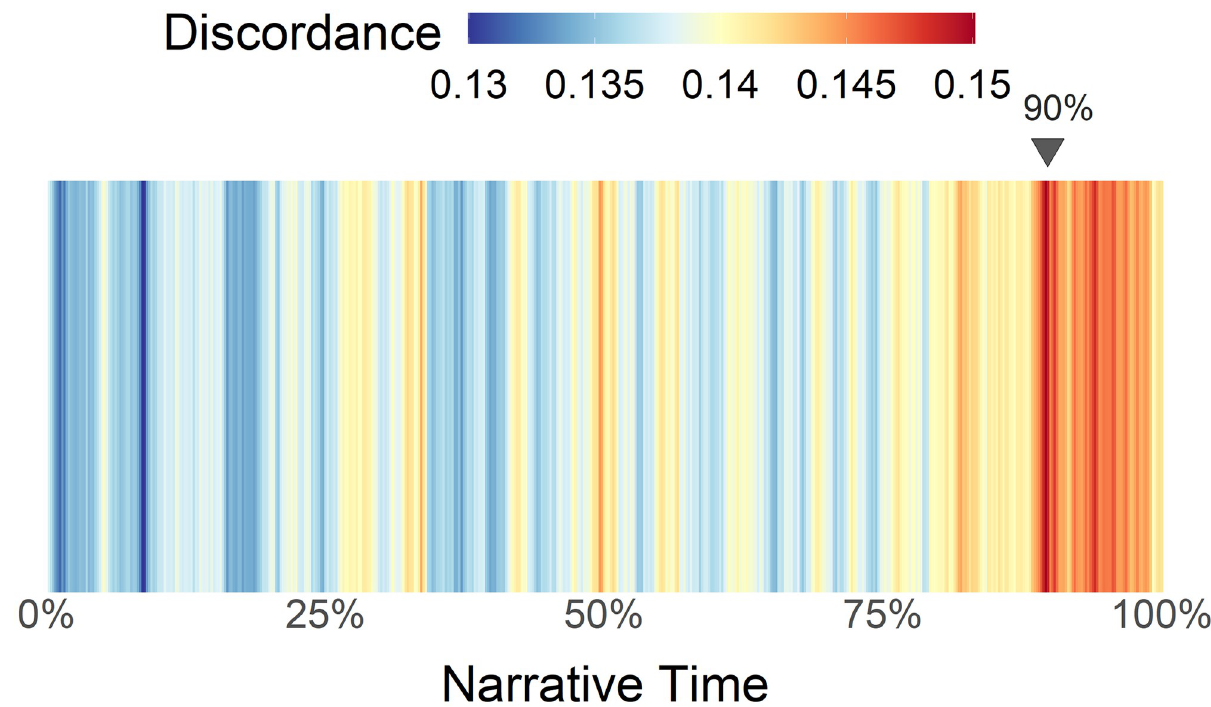
Fig 7. Average character–character discordance over narrative time ( n = 1,246,990 words). Red indicates more discordance, blue indicates less discordance. Discordance is lowest during first quarter of a movie and peaks at 90%. Score is measured in the same scale as the v-a space (i.e., 0.15 implies a Euclidean distance of 0.15 in the state